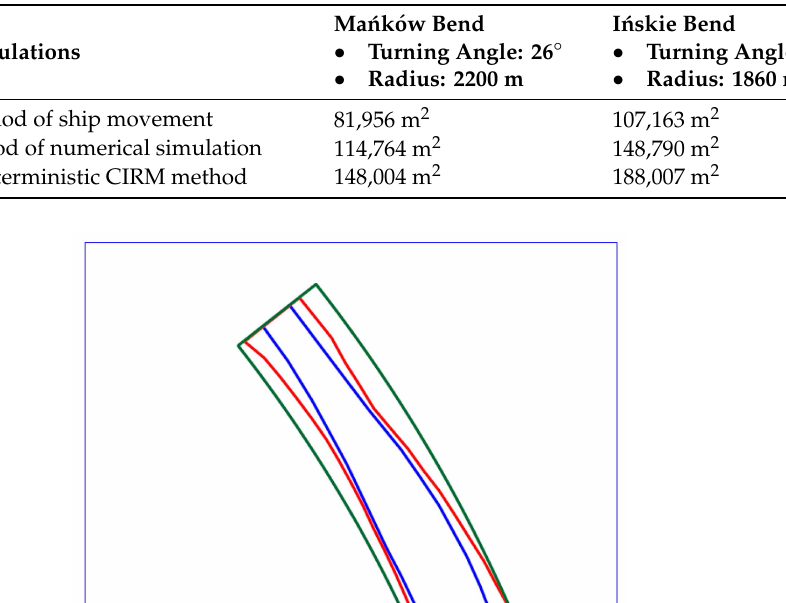
Table 3. The areas of safe manoeuvring areas of the Ma´nk ó w and I´nskie bends.